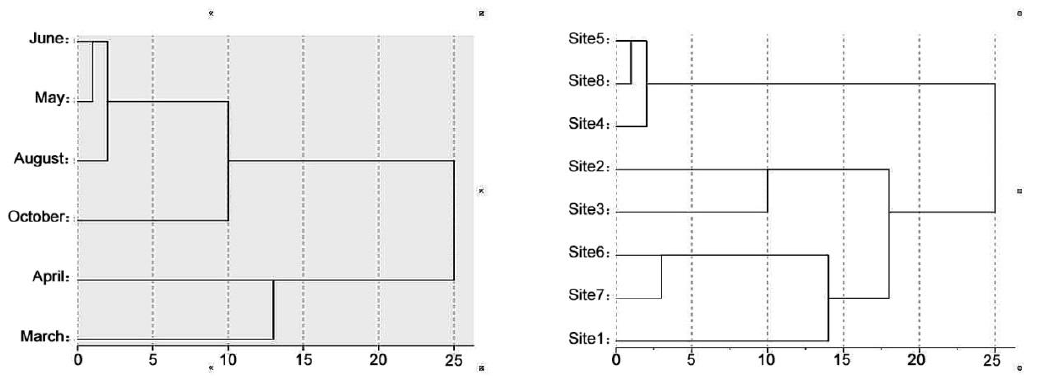
Figure 2. Dendrogram of cluster analysis for spatial and temporal variation in TSBR. ( a ) Temporal cluster analysis. ( b ) Spatial cluster analysis.